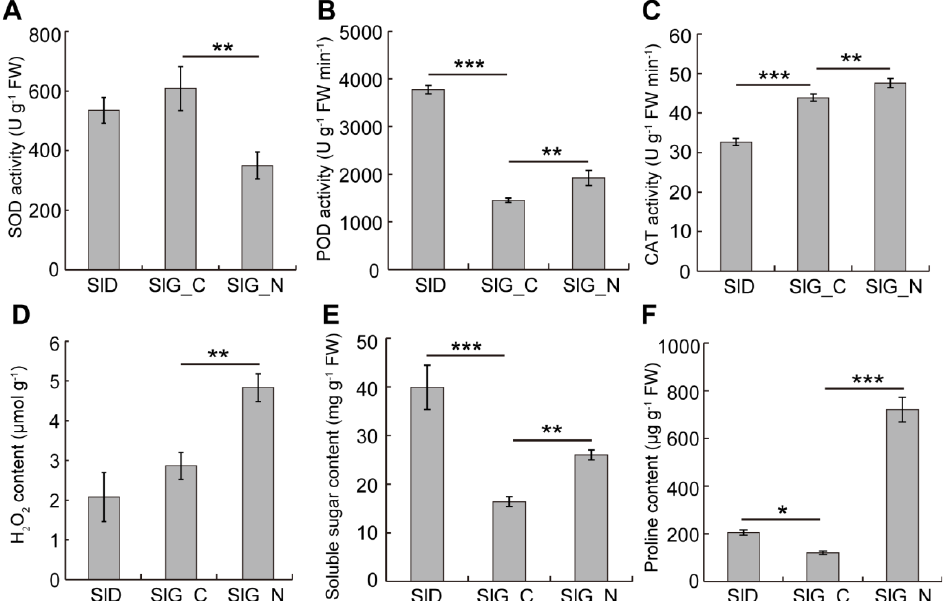
Figure 2. Determination of physiological indexes in SlD, SlG_C, and SlG_N. ( A ) SOD activity. ( B ) POD activity. ( C ) CAT activity. ( D ) H 2 O 2 content. ( E ) Soluble sugar content. ( F ) Proline content. Values presented are the means ± SD for three independent experiments. Significant differences were analyzed using one-way ANOVA followed by LSD test ( * p < 0.05; ** p < 0.01; *** p < 0.001).